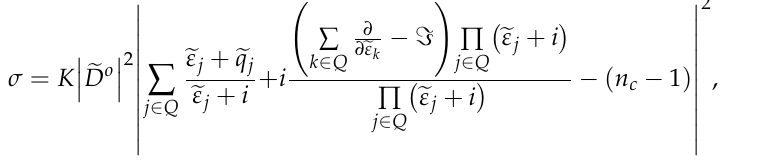
and 2 P o (from o P and 2 o P (from [45]). 3/2 1/2 3/2 1/2